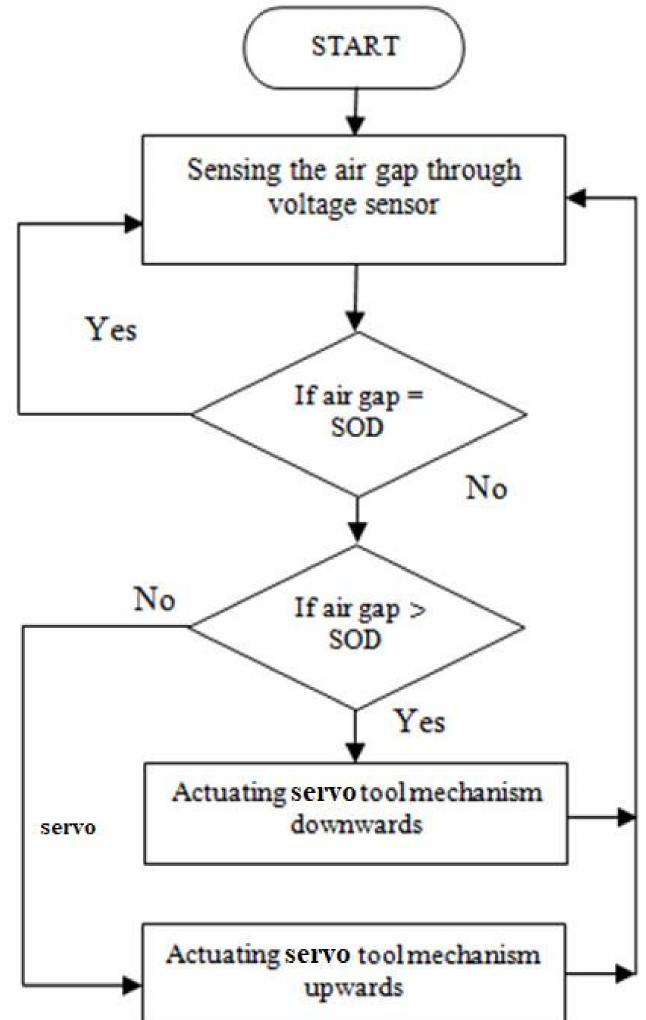
Figure 5. Flow chart for the servo tool feed control